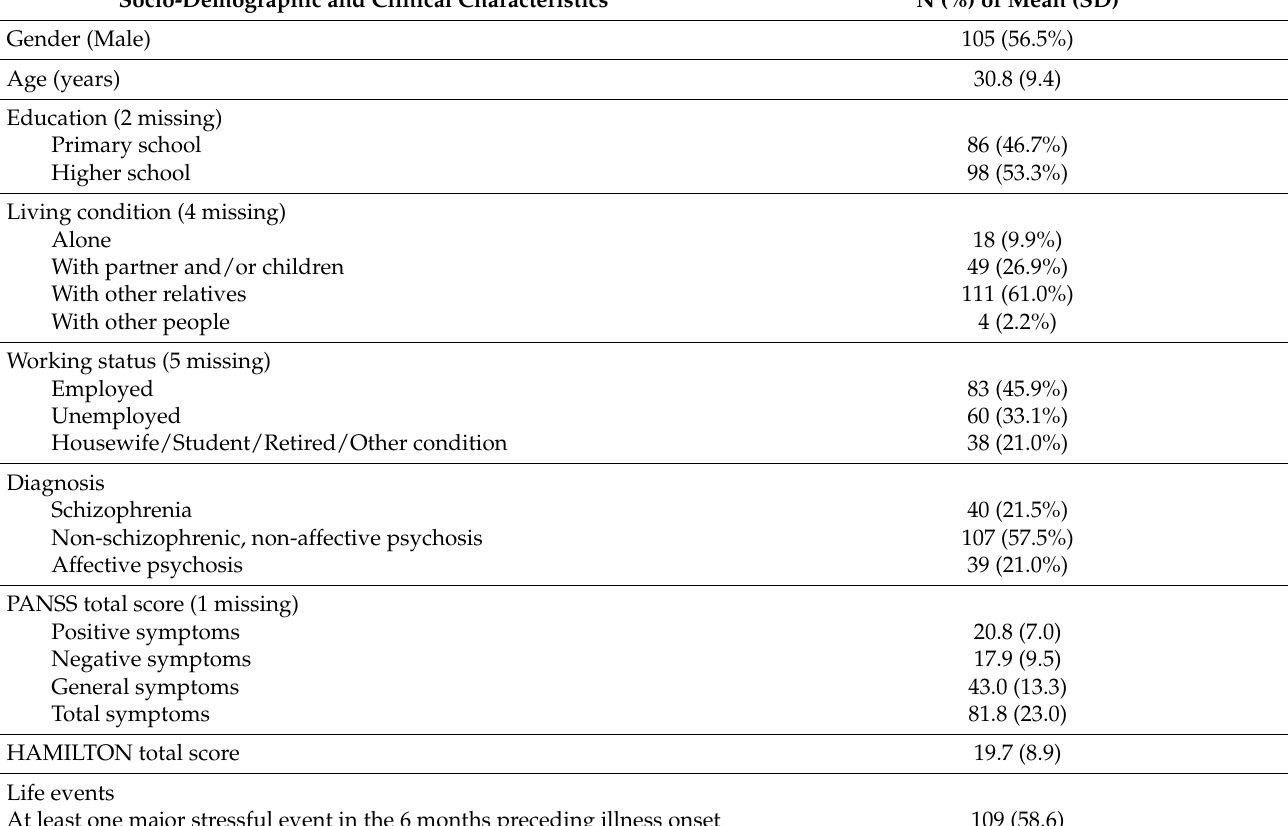
Table 1. Socio-demographic and clinical characteristics of the sample (N =